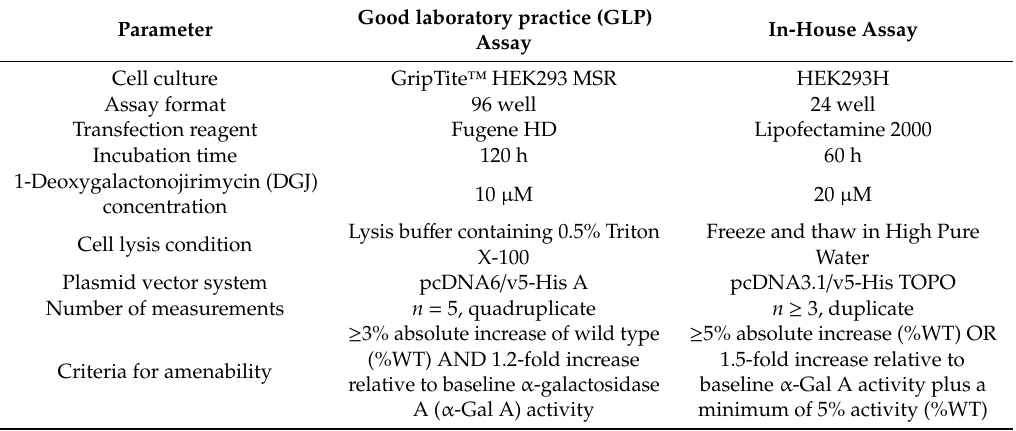
Table 1. Comparison of the good laboratory practice (GLP)-validated assay and the in-house